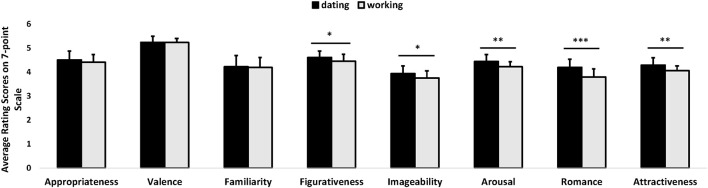
Women rated metaphorical compliments produced by male subjects in the dating context higher than in the working one across all criteria except for appropriateness, valence and familiarity. Bars show means and s.e., *p < 0.05, **p < 0.01, ***p < 0.001.